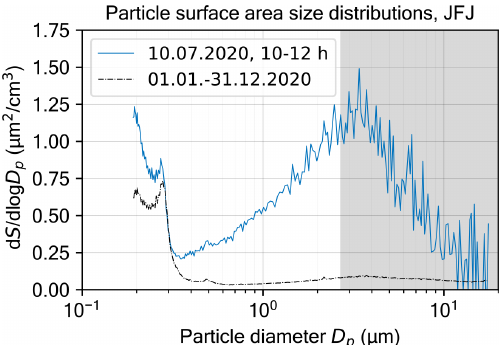
Figure A2. Mean particle surface area size distributions at JFJ during an SDE at 10:00–12:00UTC on 10 July 2020 (blue line) and between 1 January and 31 December 2020 (black dashed line), both measured with an OAS. Only particles with diameters < 2 . 5µm are sampled by HINC-Auto due to the sampling line geometry and flow rates used. All particles > 2 . 5µm (gray shading) between 7 February and 31 December 2020 contribute, during all SDE periods, 35% to the overall particle surface area. Surface area calculations assumed perfectly spherical